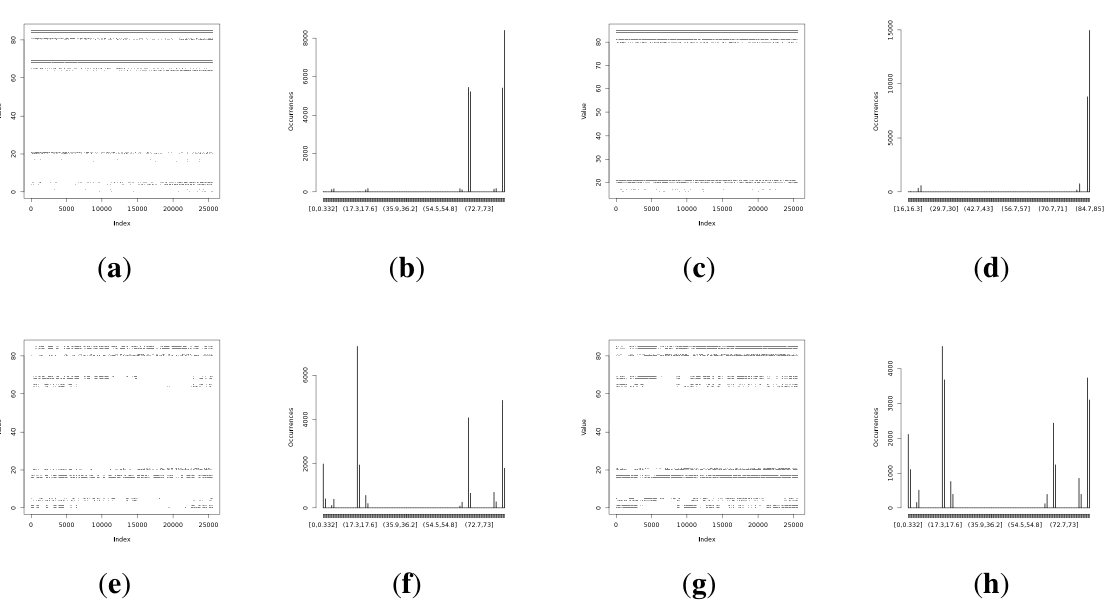
Figure 7. Initial experimental results of the harvested entropy by the fourth method in conjunction with the particular on-board sensor. ( a ) Light (1) sensor entropy; ( b ) distribution from the Light (1) sensor; ( c ) the Light (2) sensor entropy; ( d ) distribution from the Light (2) sensor; ( e ) humidity sensor entropy; ( f ) distribution from the humidity sensor; ( g ) temperature sensor entropy; ( h ) the distribution from the temperature